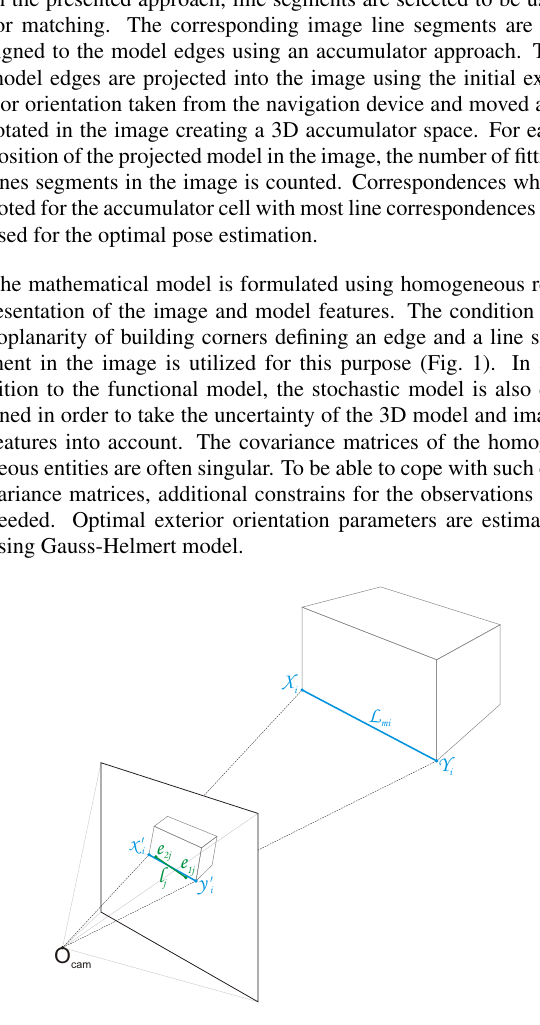
Figure 1: Principle of assignment of image line segments to 3D model